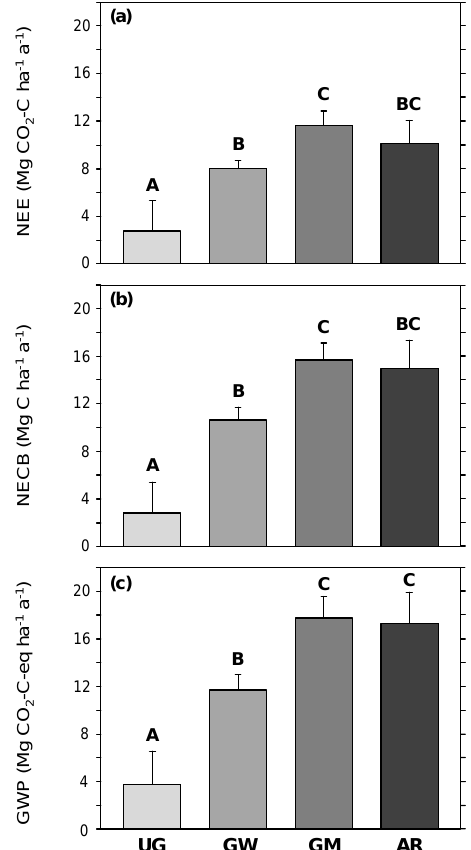
Figure 7. Mean annual budgets of net ecosystem exchange (NEE) of CO 2 (a) , net ecosystem carbon balance (NECB; b ) and global warming potential (GWP; c ) at the four study sites for the period April 2012–March 2014 ( n = 6). Error bars represent standard error. Different capital letters indicate significant differences between the sites ( p